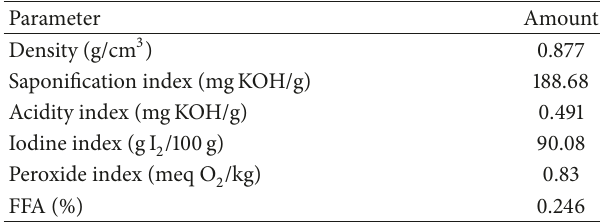
Table 1: Physicochemical parameters of the raw rice bran